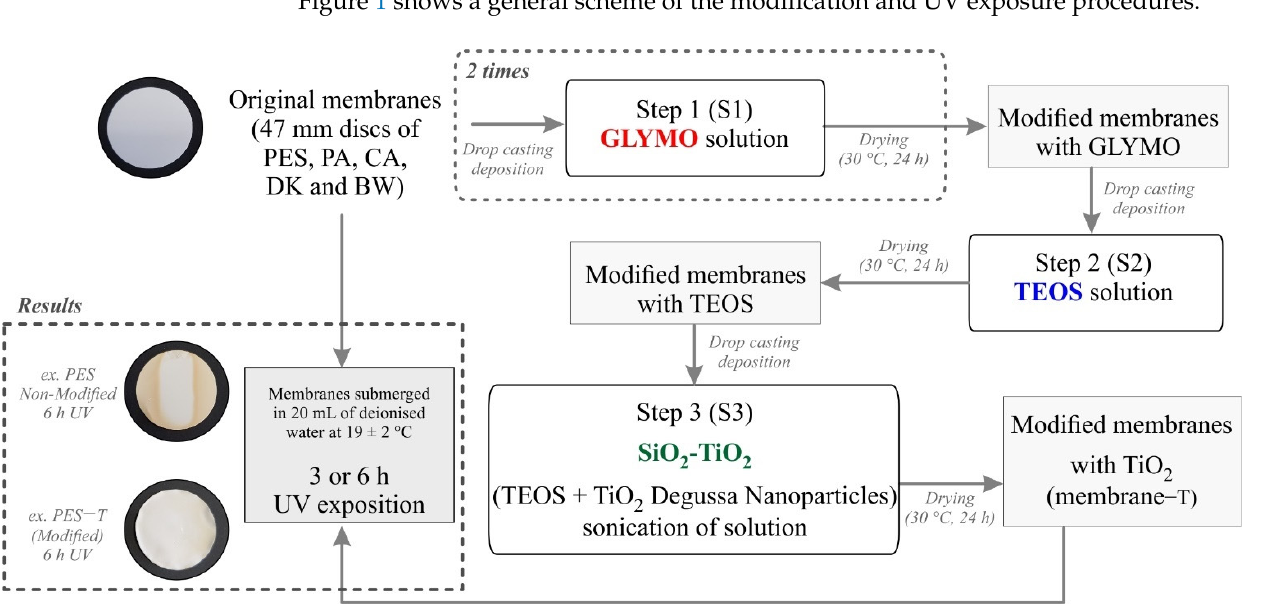
Figure 1. Flow chart depicting the sol–gel procedure followed to coat polymeric membranes with TiO 2 and the UV exposure assays conducted to evaluate the membranes’